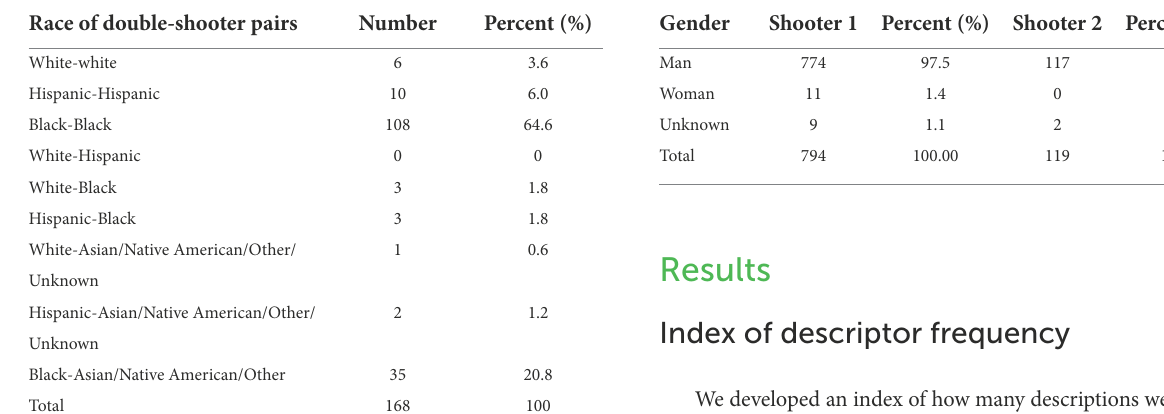
TABLE 7 Gender of shooters in final subsample. TABLE 3 Race of double-shooter pairs in overall sample.